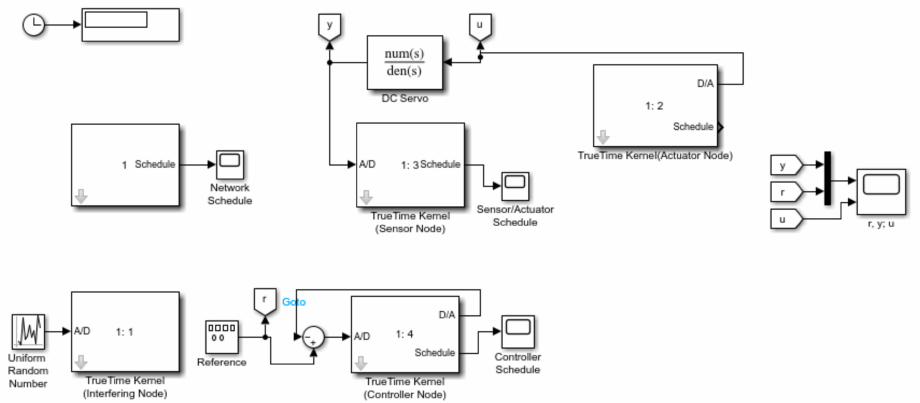
Figure 11. Network control system built with True-Time.